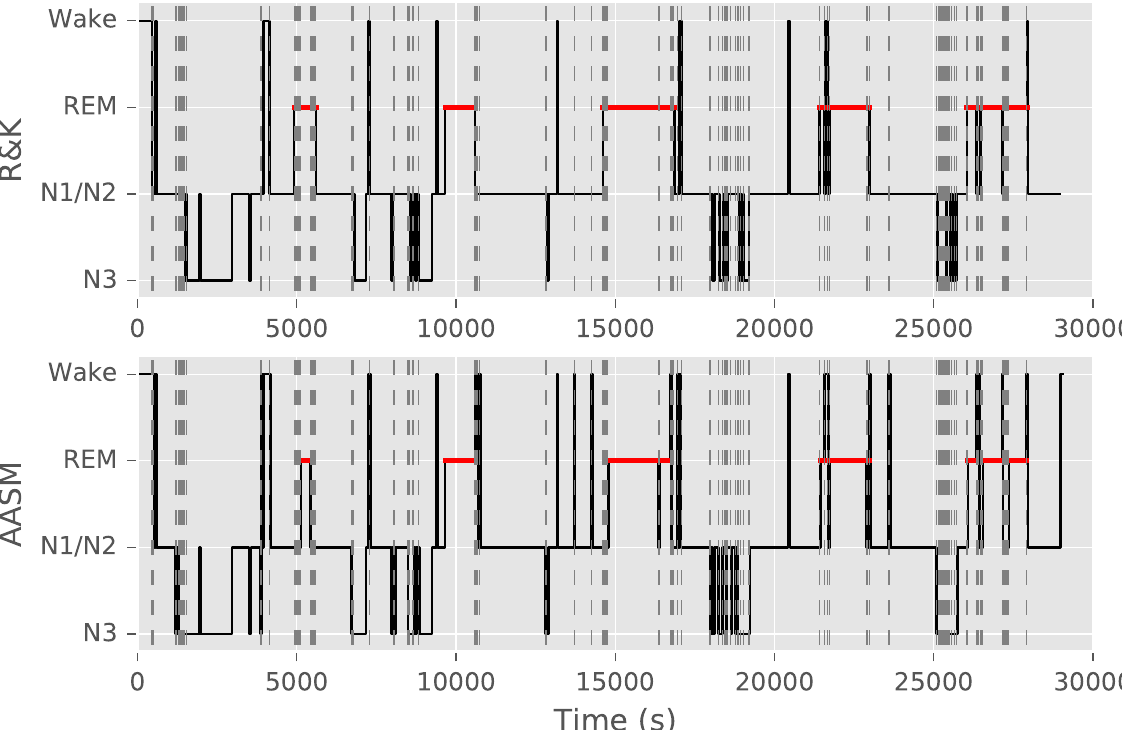
Fig. 1 Sleep hypnogram from the Siesta database simultaneously annotated according to R&K and AASM annotation standards. Due to differences in annotation rules, a total of 59 min of this night were differently annotated (differences highlighted with vertical grey stripes). Note that some changes may also be related to inter-rater disagreement. For ease of visual comparison, instead of presenting full hypnograms, this fi gure shows only 4-class hypnograms (Wake, REM sleep, N1/N2 sleep, and N3 sleep), which is also the objective of automatic sleep stage classi fi cation in this